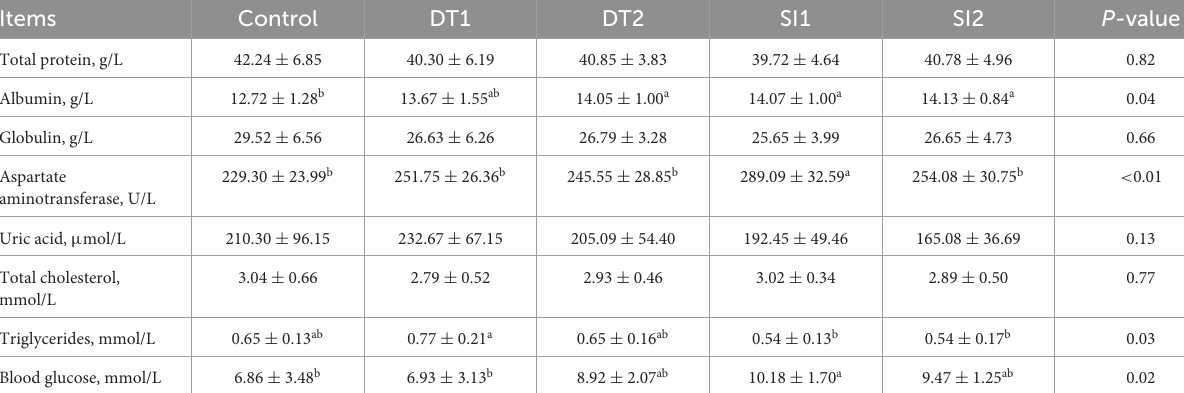
TABLE 4 Effects of dietary supplementation with dandelion tannins or soybean isoflavones on serum biochemical indexes of Wenchang chickens.